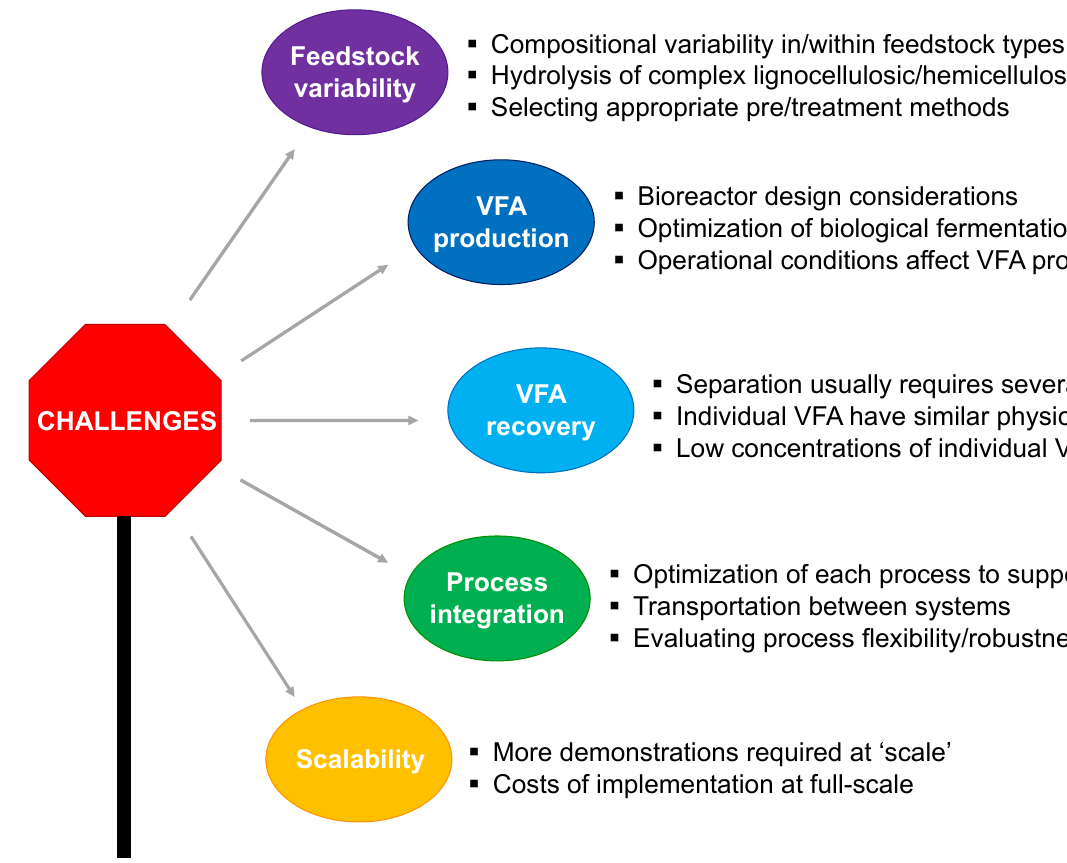
Figure 3. Challenges and opportunities for future research. The promise of a biorefinery-based bioeconomy will rely on innovative and interdisciplinary solutions. The literature suggests that key challenges with respect to feedstock variability, VFA production and recovery, process integration, and scalability all need to be tackled.